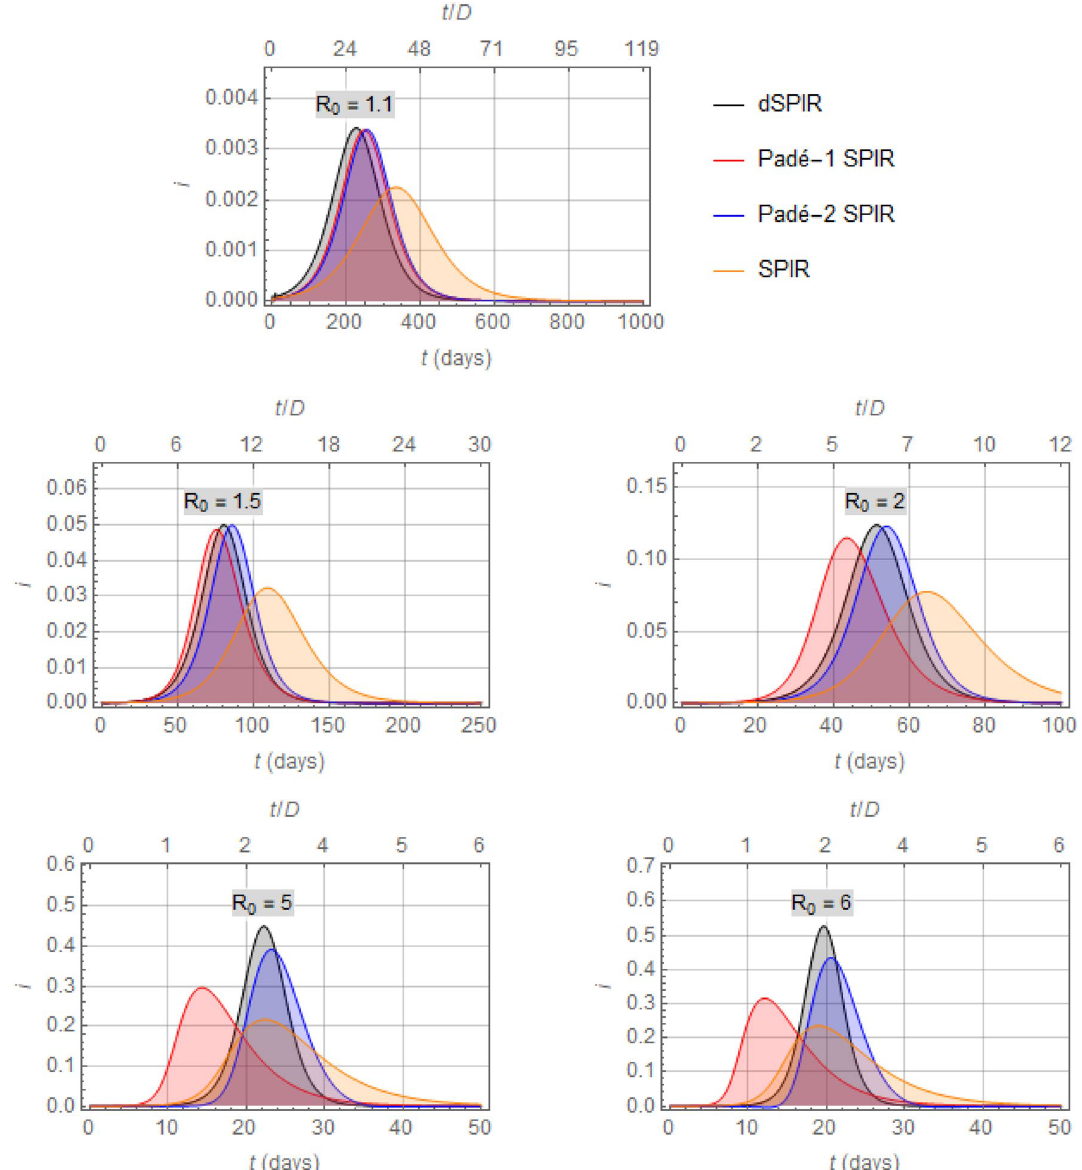
Figure 11. Comparison of the infectious fraction, i , produced by the dSPIR, Padé-1 SPIR, Padé-2 SPIR,